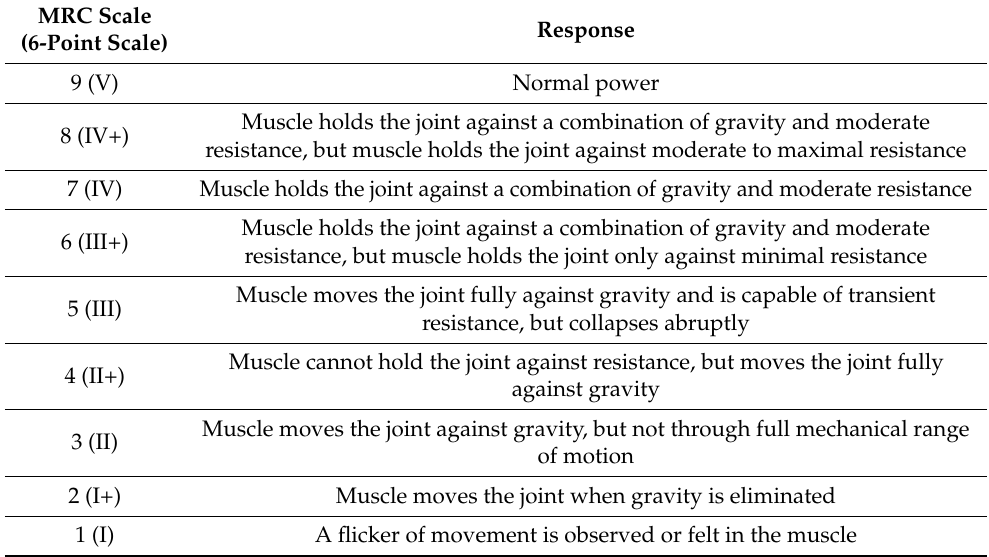
Table 1. Modified MRC scales for assessing proximal weakness. MRC, Medical Research